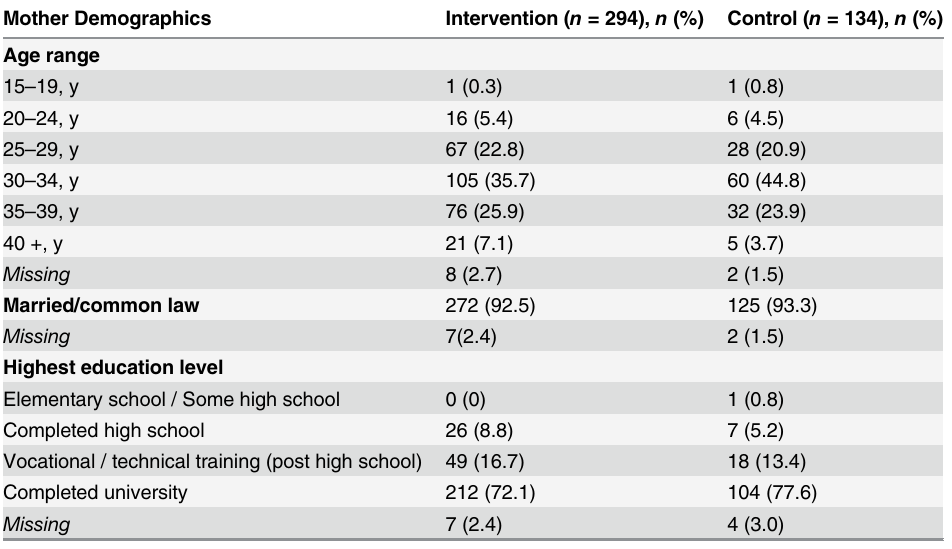
Table 1. Mother Demographics